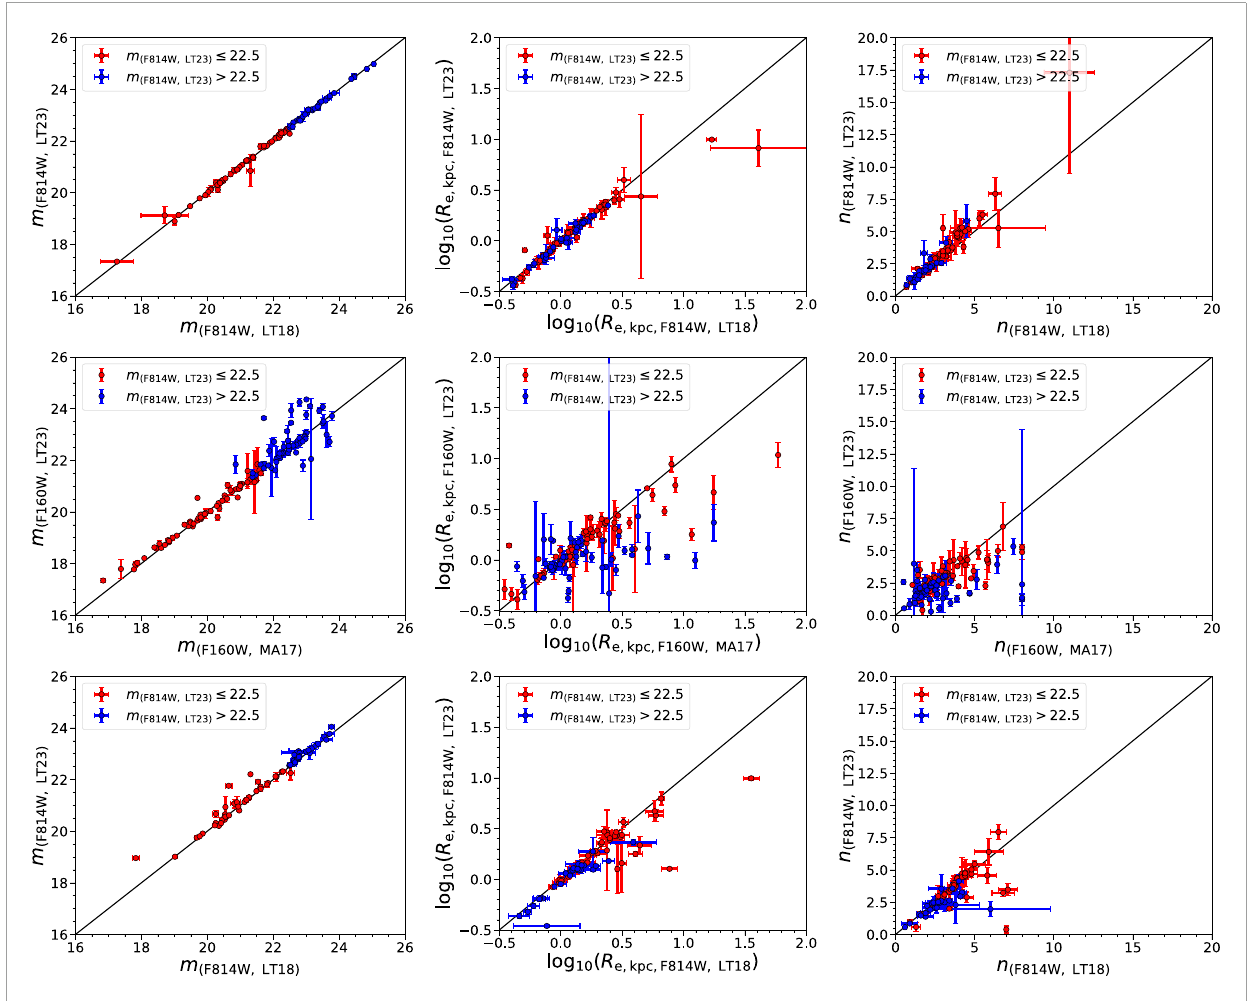
FIGURE 7 The panels show the comparison between the magnitudes, the log 10 R e , with R e in kpc , and the Sérsic indices in LT23 and those of LT18 (top and bottom panels) and MA17 (middle panels). LT18 structural parameters are measured for AS1063 and M1149, while MA17 for M0416. The comparisons with LT18 are in the F814W waveband, while the comparison with MA17 in the F160W waveband. In all panels, red points represent galaxies with magnitude m ≤ 22.5 in the F814W waveband, while blue points represent galaxies fainter than this limit in the same waveband. The black solid lines represent the one-to-one